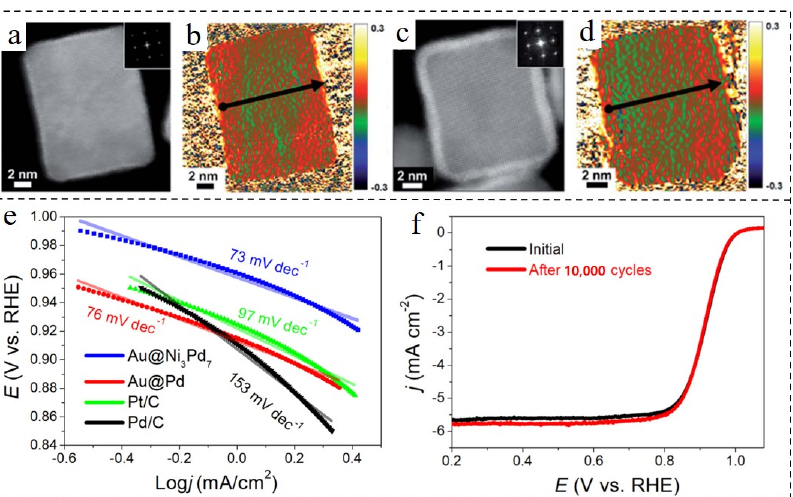
Figure 9. HAADF-STEM images and corresponding GPA for the 2–4 ML ( a , b ) and 5–7 ML ( c , d ) shelled Pd@Pt nanocubes. Reproduced with permission from [32]. Copyright © 2022, Royal